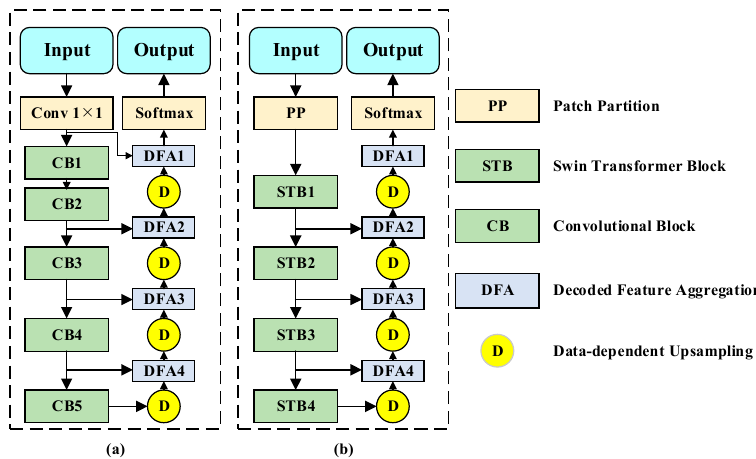
Figure 11. The pipelines of ( a ) CB ‐ only encoder, ( b ) STB ‐ only encoder.